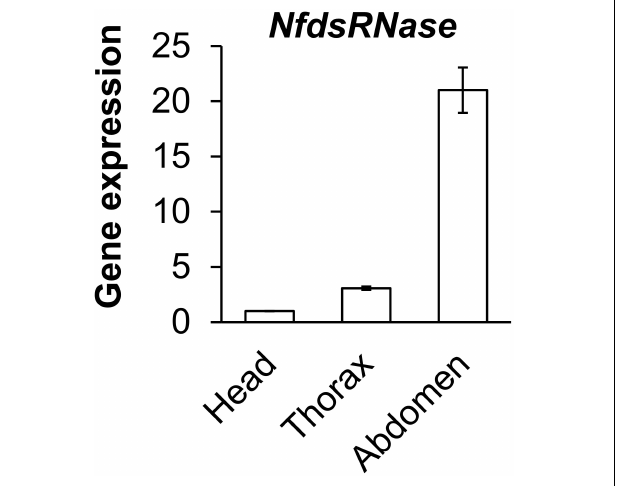
FIGURE 4 | Relative expression of NfdsRNase in head, thorax and abdomen of worker ants. Gene expression was determined by RT-qPCR, with 60S ribosomal protein L4 served as the internal